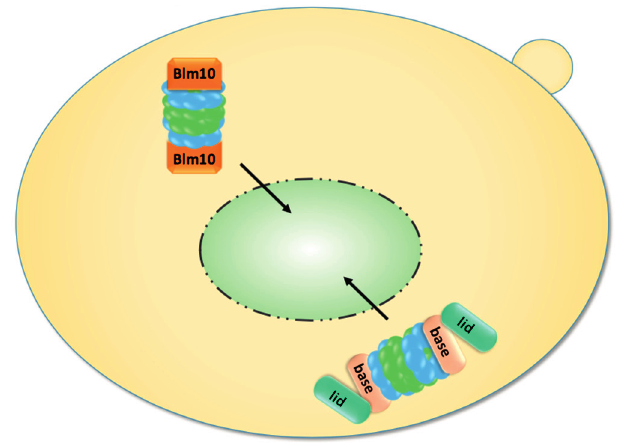
Figure 3. Upon exit from quiescence, mature proteasomes are imported into the nucleus. They are either imported as holo-enzymes or by Blm10, which facilitates the nuclear import of mature